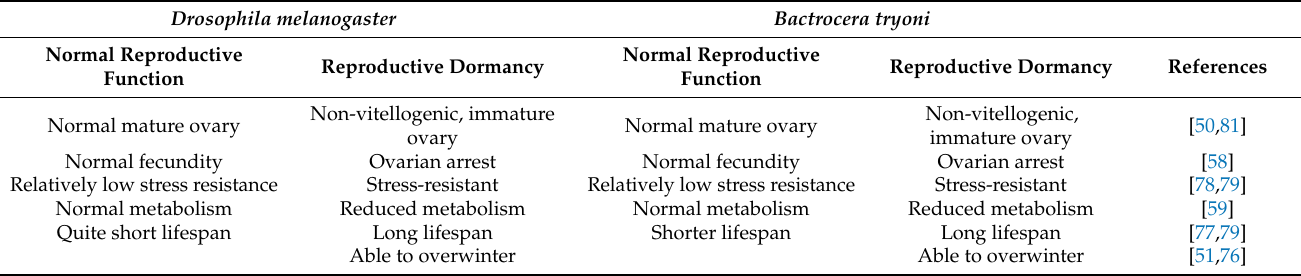
Table 1. Comparison of the recognised non-dormancy and dormancy reproductive states of Drosophila melanogaster with the proposed non-dormancy and dormancy reproductive states for Bactrocera tryoni . The information for D. melanogaster is extracted from Figure 3 in Flatt et al. [87] and is fully referenced by them: the references provided are just for B. tryoni